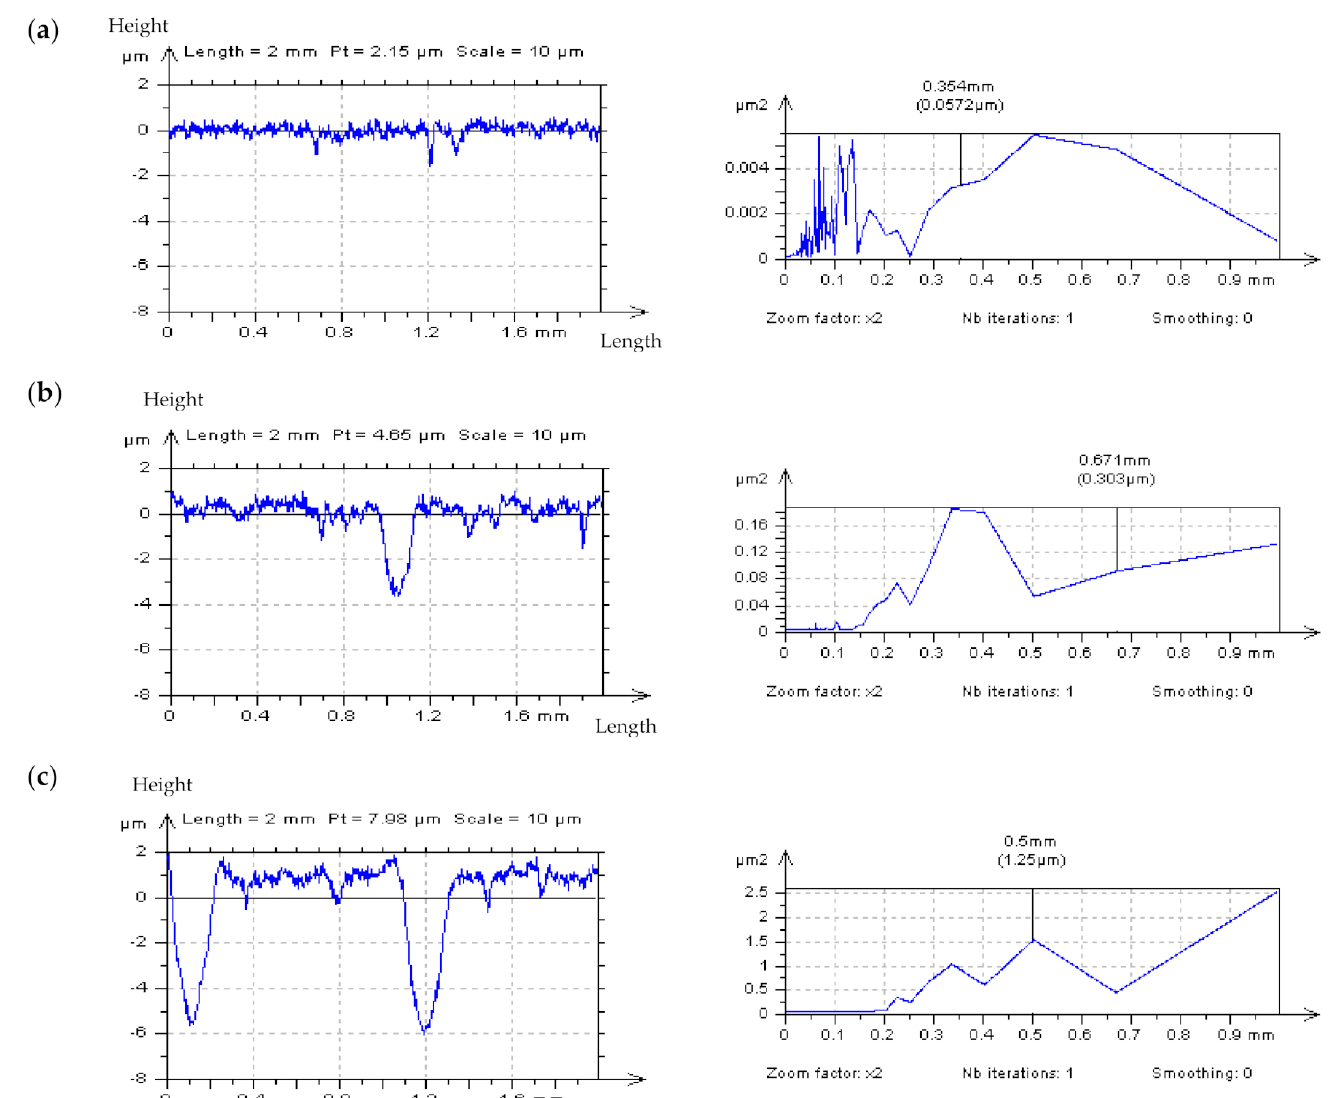
Figure 2. Measured with stylus instrument at 0.5 mm/s speed profiles and their PSDs, respectively, extracted from the plateau-honed cylinder liner texture, examples provided for ( a ) non-valley, ( b ) one-valley, and ( c ) two-valley